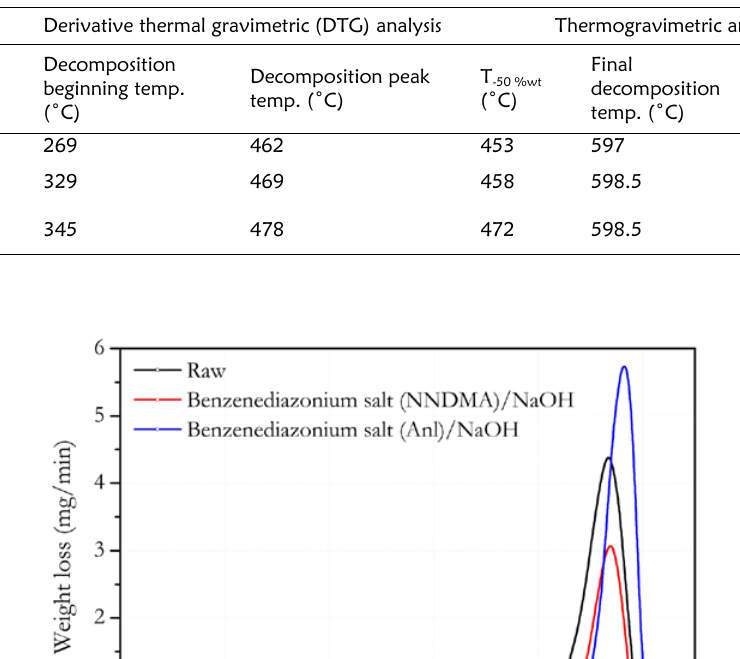
Table 1: Decomposition temperature of 35 wt% WH-PP composites